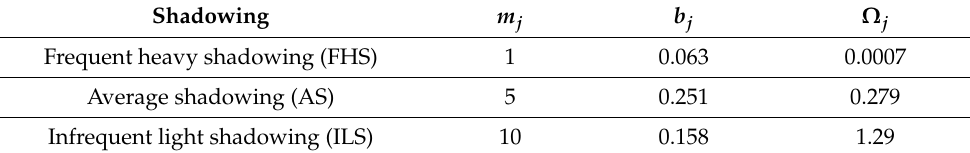
Table 2. Channel parameters.